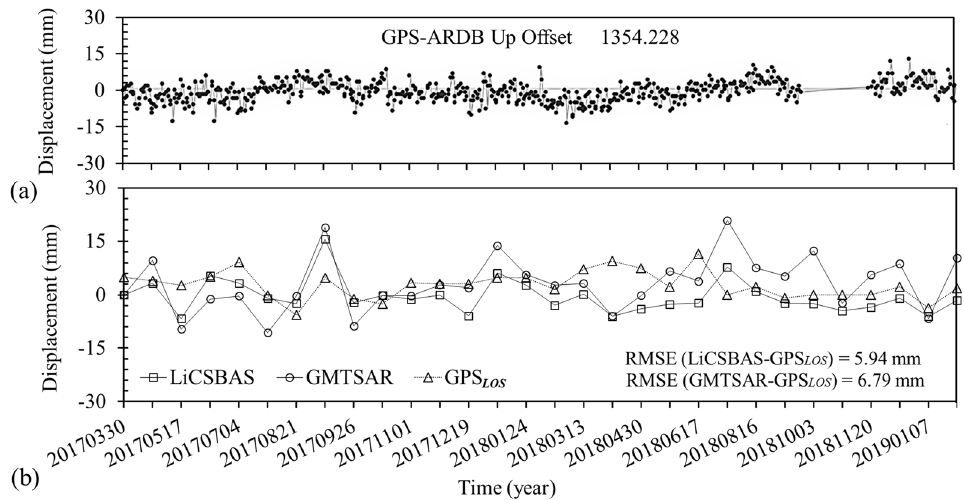
Figure 17. Comparison of the GPS and InSAR time-series of LiCSBAS and GMTSAR results: ( a ) Displacement trends from 2017 to 2019 of GPS permanent station (https:// ipgn. ncc. gov. ir/ pggn/) . ( b ) RMSE between the InSAR and GPS LOS time-series from 2017 to 2019.